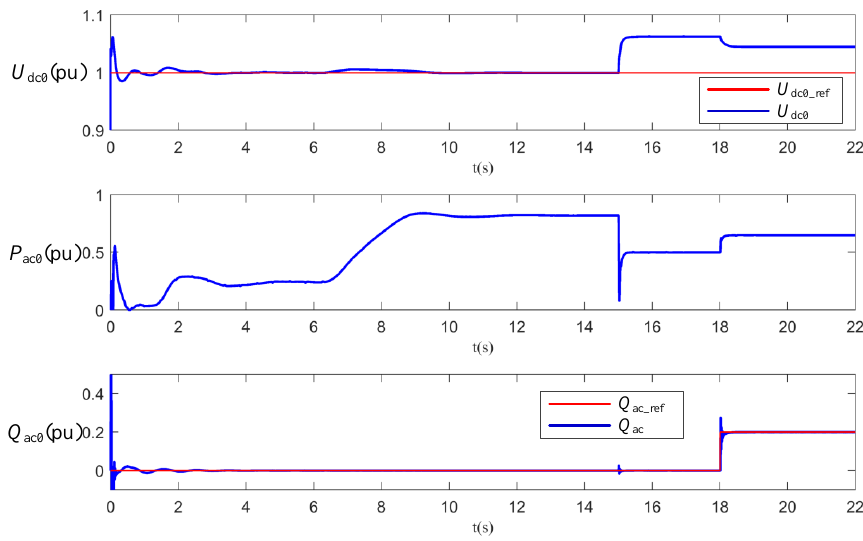
Figure 12. DC voltage, active power and reactive power of DC/AC converter.